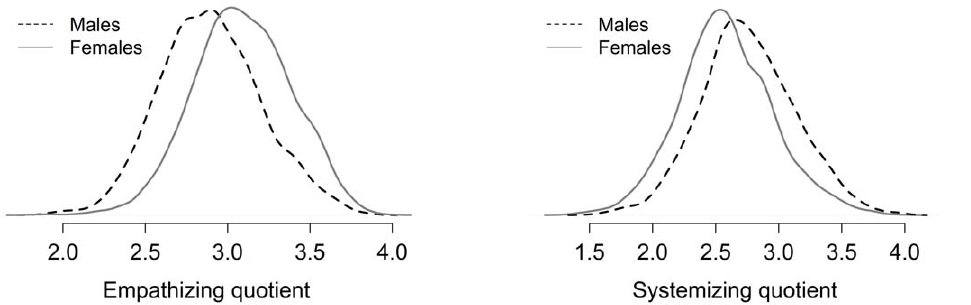
Figure 6. The distribution of mean responses for males and females for the EQ (left panel) and the SQ (right panel). The distributions are drawn using a Gaussian kernel estimation method (the R default).